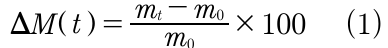
Figure 5: Test specimen after impact test removed, patted dry with a lint free cloth, and weighed. It is measured using meter balance. The Figure 6 shows the soaked specimen and measuring of its weight. The percentage of water absorbed by the composite material was calculated by using weight difference between the samples immersed in water and the dry samples using Eq.